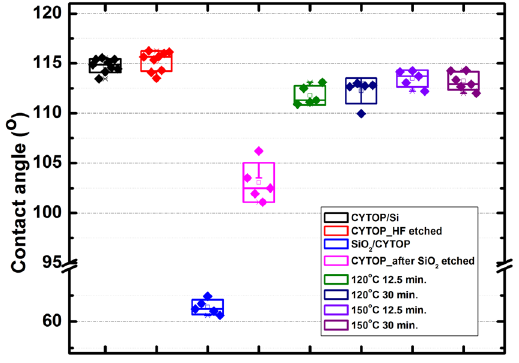
Figure 5. Contact angle measurement results during the photolithography